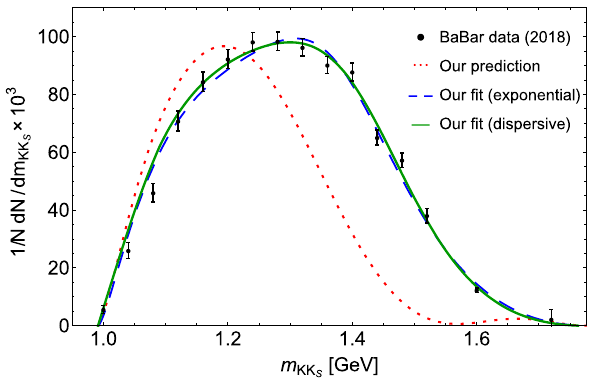
Fig. 6 BaBar data [16] for the decay τ − → K − K S ν τ (black solid circles)confrontedtoourprediction(dottedredcurve),asforourcentral results of the pion vector form factor analysis presented in Eq.(42), and fits with the exponential representation (dashed blue curve) and the dispersive approach with s cut = 4 GeV 2 (solid green